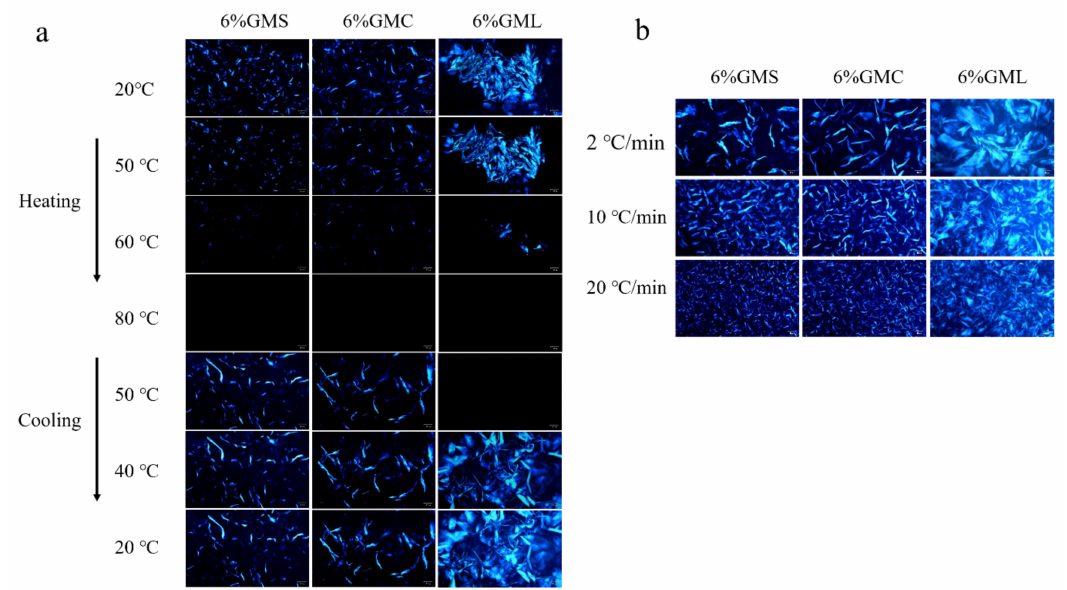
Figure 5. Polarized light microscopy images of oleogels during heating and cooling process with the rate of 2 ◦ C/min ( a ) and with different cooling rates (2, 10 and 20 ◦ C/min) ( b ). The scale bar is 50 µ